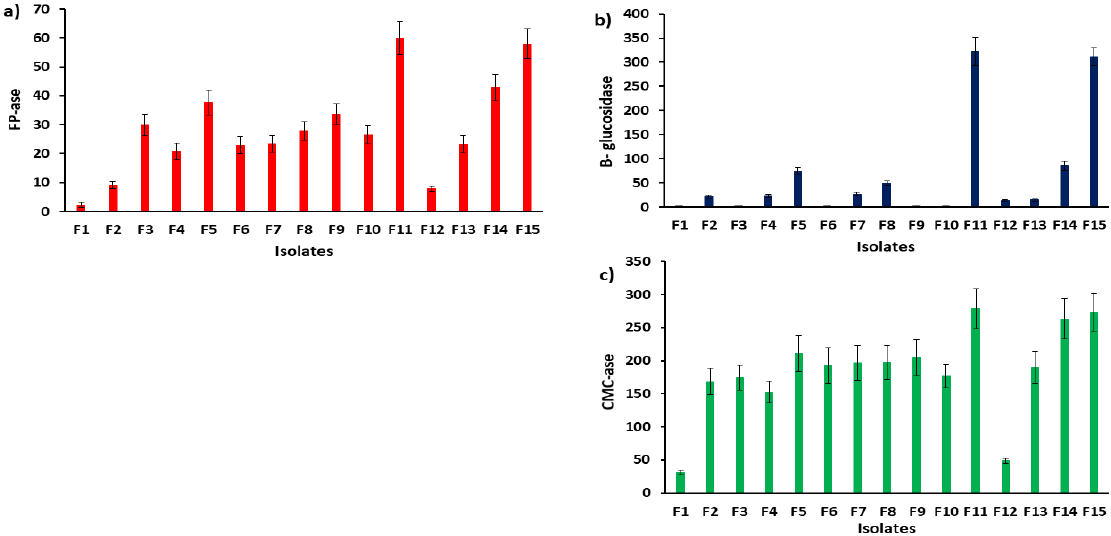
Figure 4. The activity of CMCase cellulases in the filtrates of different isolated